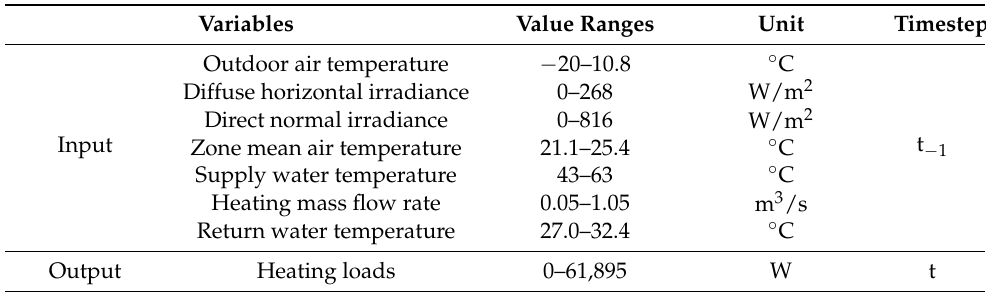
Table 5. Input parameters.